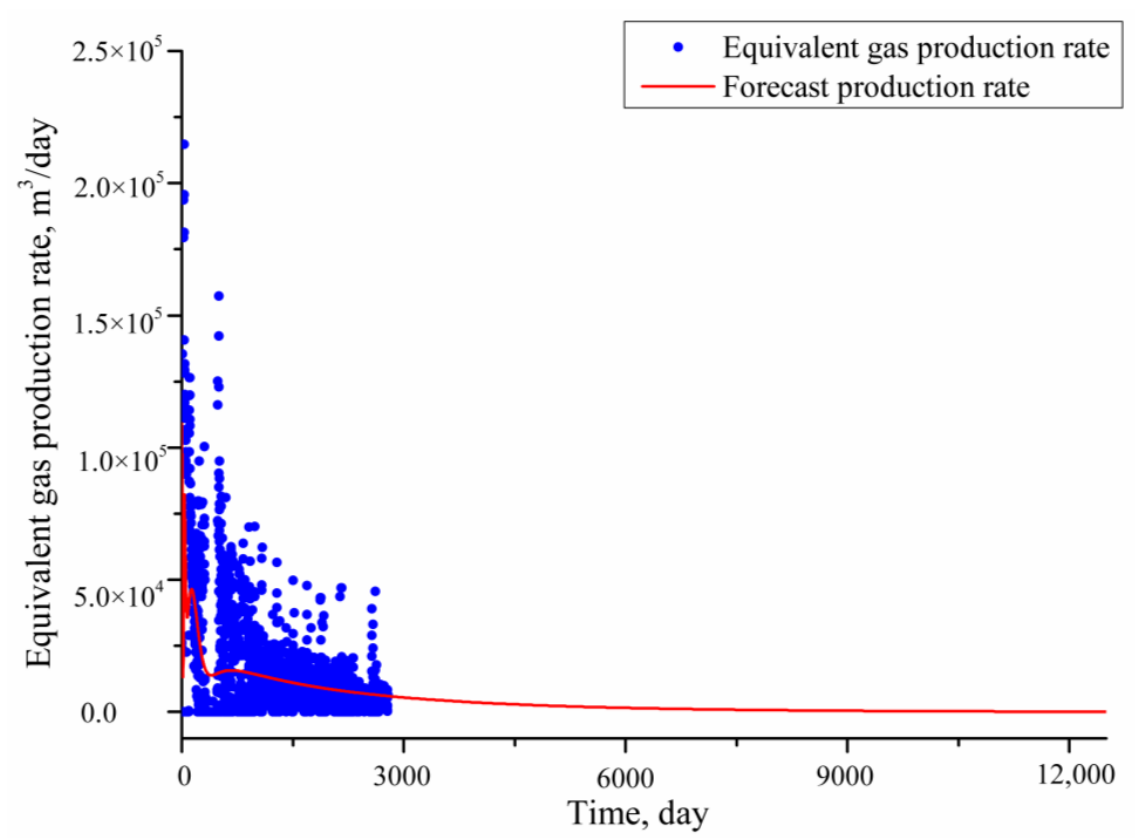
Figure 13. The fitting effect between the equivalent gas production calculated by the mathematical model and the real equivalent gas production.